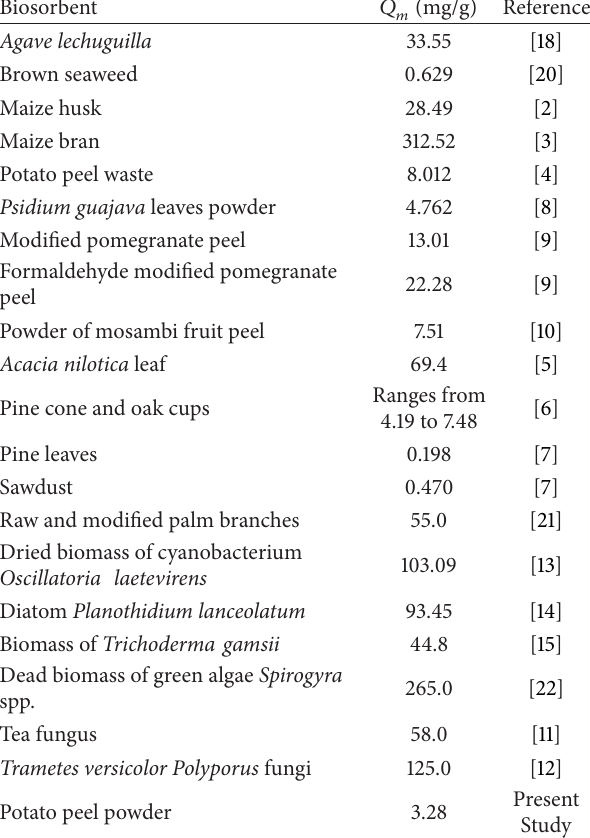
Table 3: Comparison between the results of this work and other results found in the literature for the monolayer maximum adsorp- tion capacity of Cr(VI) ions with various